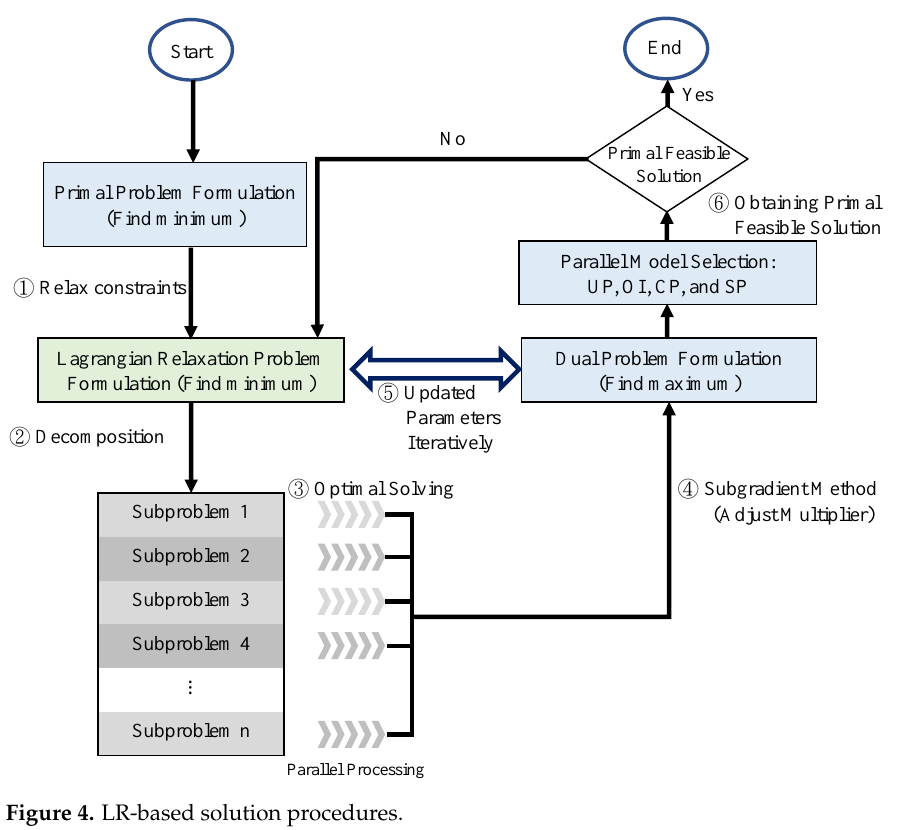
Figure 4. LR-based solution